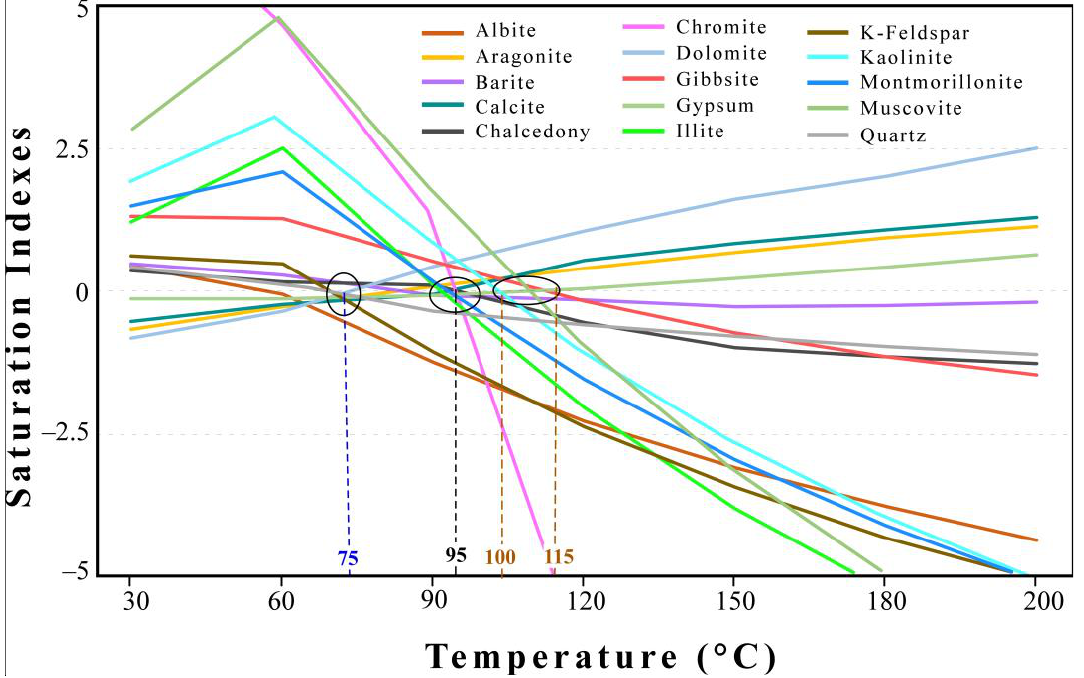
Figure 10. Saturation indexes (in log(Q/K)) of the thermal water Goutitir in different minerals and temperatures.